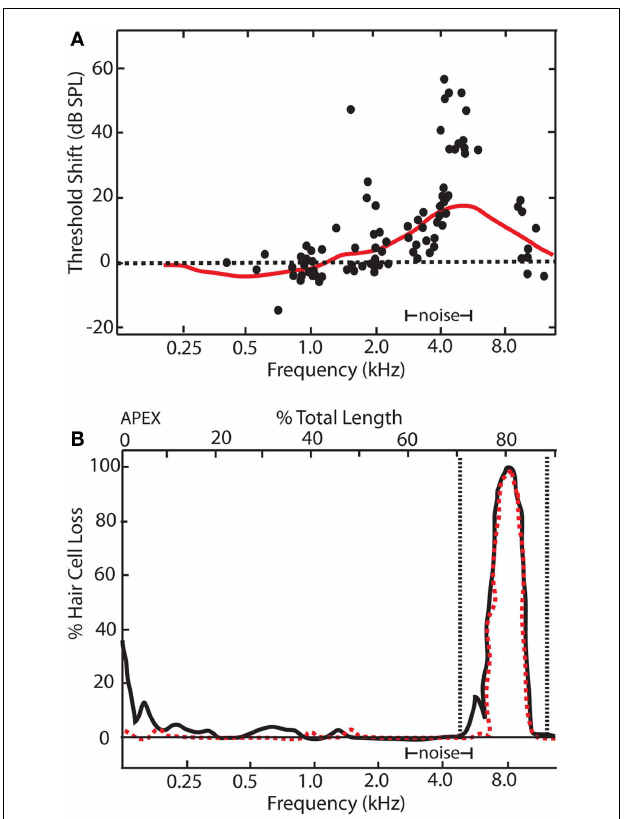
FIGURE 2 | Relationship between electrophysiological and behavioral threshold shifts . (A) Schematic showing temporary threshold shifts in adult chinchillas that were exposed to an octave band noise centered at 4kHz with 86dB SPL amplitude for 5days. Electrophysiological recordings of auditory nerve fibers revealed thresholds shifts of up to 70dB SPL at characteristic frequencies between 4 and 11kHz (black dots). However, behavioral audiograms (red line) revealed relatively smaller behavioral threshold shifts in comparison, ranging from 5 to 20dBs SPL at frequencies between 4 and 11kHz. (B) Cochleogram showing narrow lesions of inner (dotted red line) and outer hair cells (black line) over the 1mm that correlated with the frequency of the electrophysiological and behavioral threshold shifts [modified from Ref.